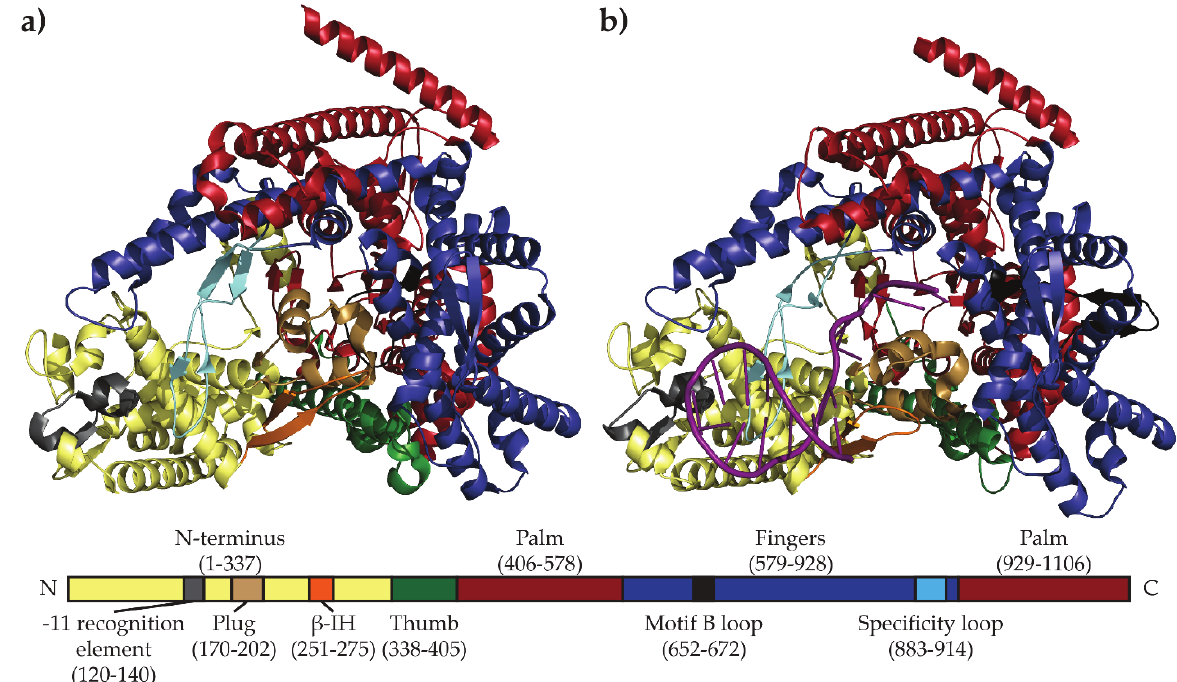
Figure 3. Comparison of the mini-vRNAP apo (Accession number 2PO4) ( a ) and BC (Accession number 3C3L) ( b ) structures highlighting rearrangements near the enzyme active site. Both structures show “cupped right hand” architecture (thumb, palm, fingers) characteristic of this family of RNAPs. Upon promoter binding, large scale structural rearrangements of the plug and (cid:3)-IH motif occur, allowing the rearrangement of the motif B loop into the O helix to allow single-stranded DNA access to the active site. Bottom bar represents the mini-vRNAP primary sequence with amino acid numbering indicated in parentheses. Domains and structural motifs are labeled and colored as in the crystal structures, with template strand DNA represented as a purple